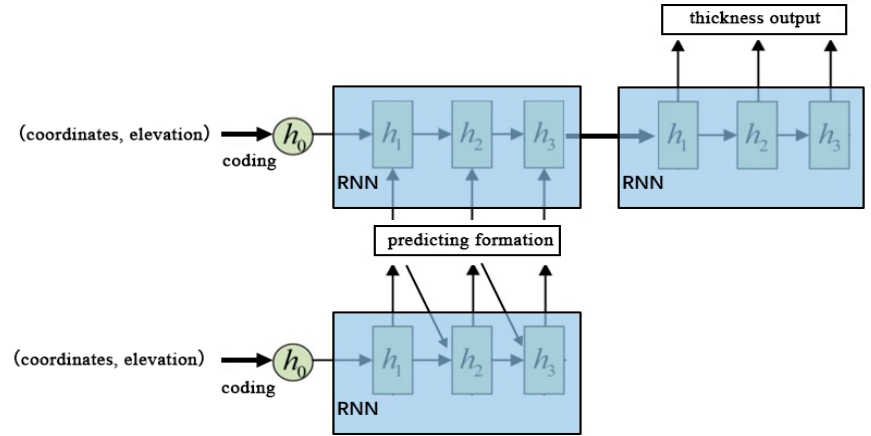
Figure 5. Diagram of the neural network structure for stratum prediction.